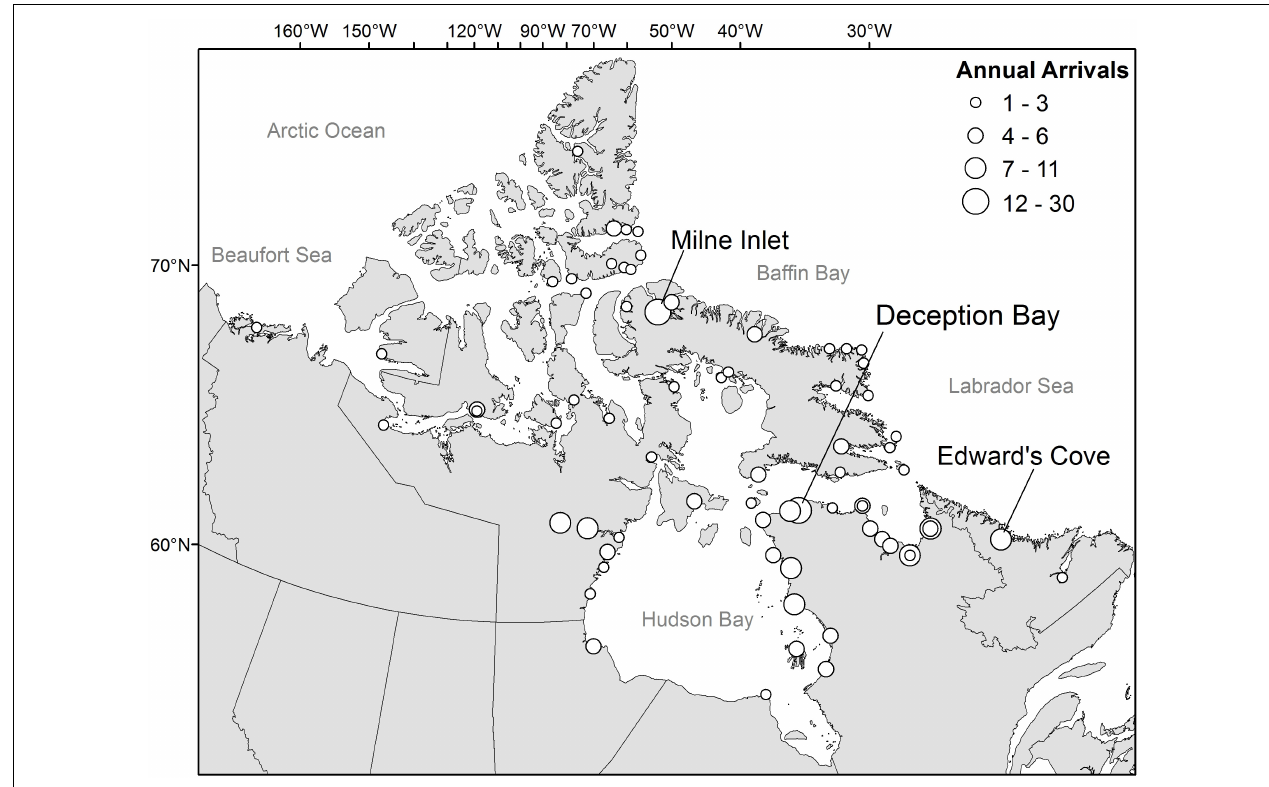
FIGURE 1 | Number of annual arrivals at 73 Canadian Arctic ports during 2015–2016, based on data collected from the questionnaire survey. The three most visited ports by respondent ships were Deception Bay, QC, Milne Inlet, NU, and Edward’s Cove, NL.